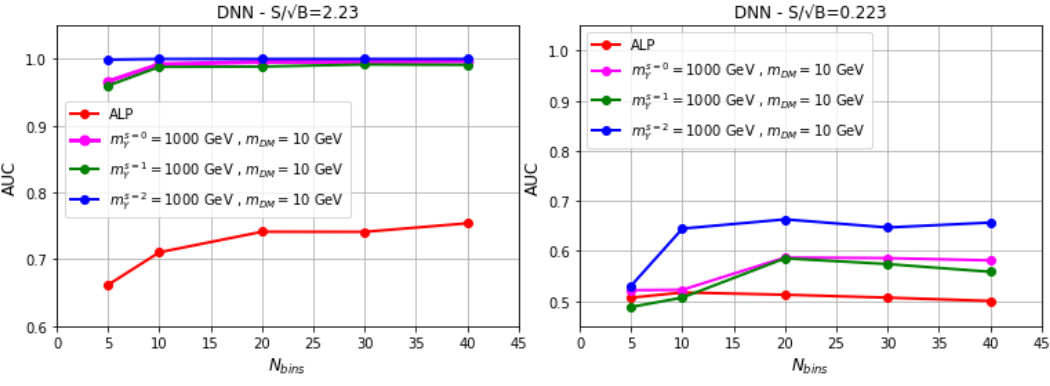
Figure 28: AUCs for histograms constructed with different number of bins, N The benchmark models dubbed on-shell are used, with S / (cid:112) B = 0.223 (right and S /